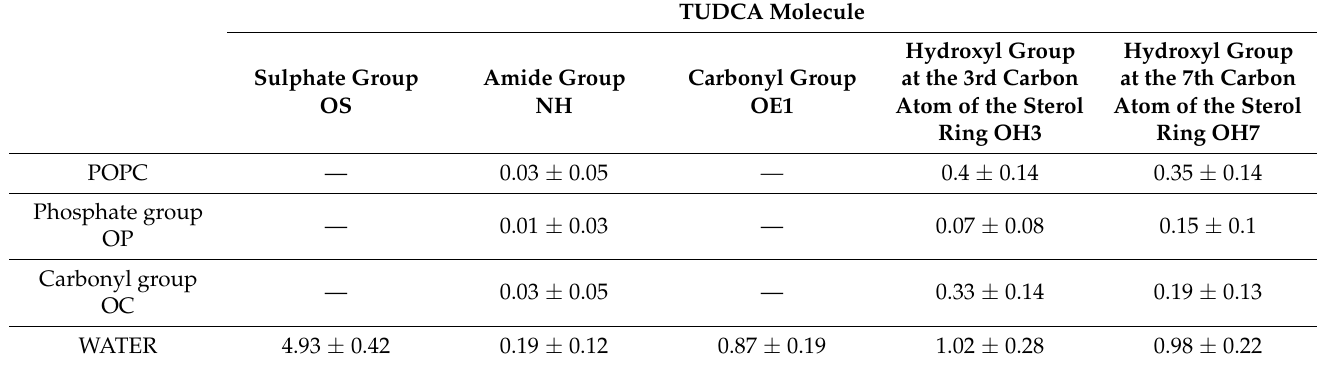
Table 2. Average (by time and number of TUDCA molecules) number of hydrogen bonds between TUDCA (considering single atoms) and POPC (considering oxygen atoms of phosphate and carbonyl groups) and between TUDCA and water. POPC: OP–phosphate group, OC–carbonyl group, TUDCA: OS–sulphate group, NH–amide group, OE1–carbonyl group, OH3 and OH7–hydroxyl groups at the 3rd and the 7th carbon atom of a sterol ring, respectively. Only TUDCA molecules which are present in the membrane are